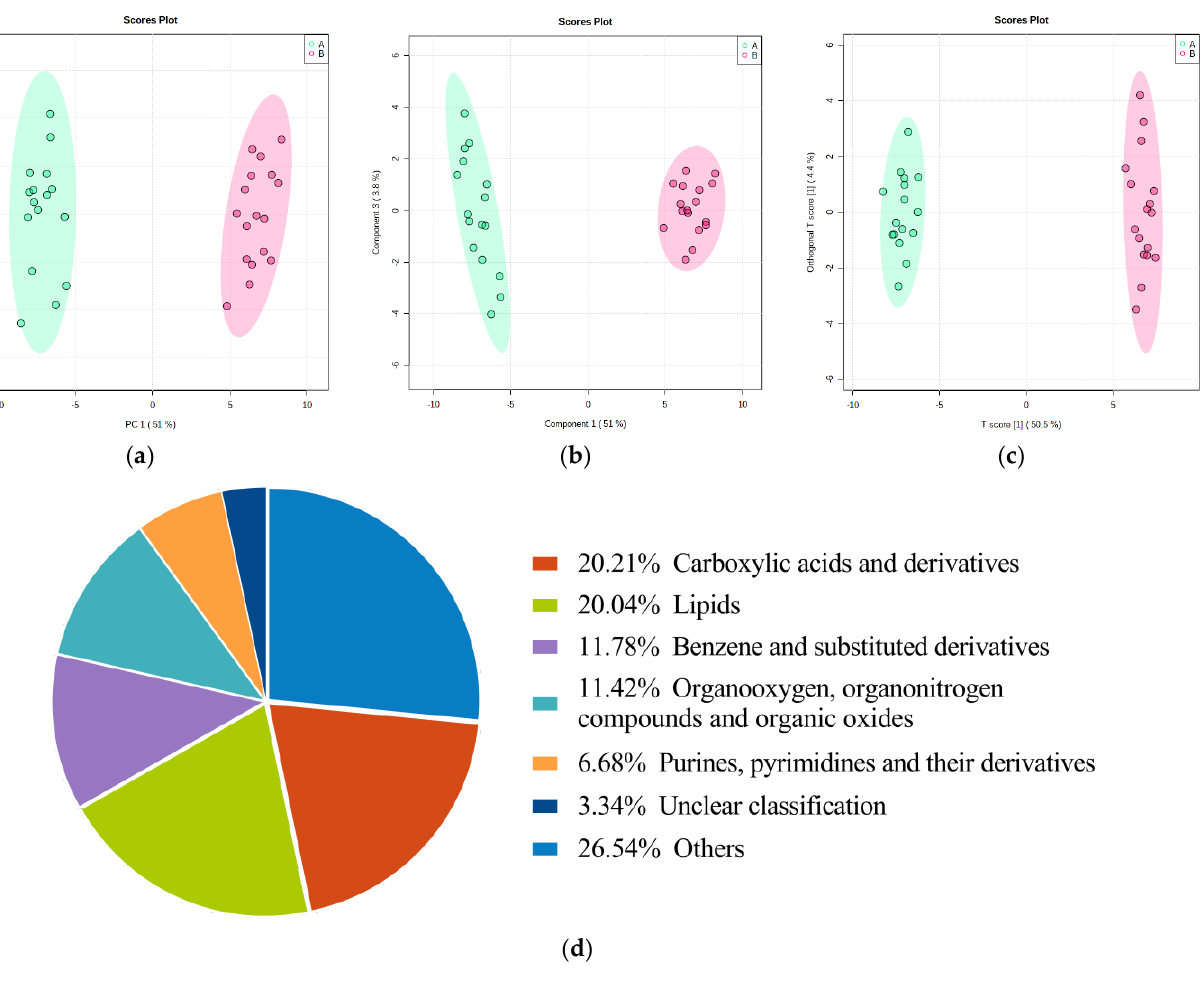
Figure 1. Score plots of the PCA/PLS-DA/OPLS-DA models for discriminating the GV-H group from the GV-L group and pie chart of preliminary differential metabolites screening results in the exploratory set. Samples of these two groups were distinctly separated, indicating that they had markedly different metabolic characteristics ( a – c ). Pie chart ( d ) of differentially metabolomics showed that the 569 metabolites mainly involved carboxylic acids and derivatives (20.21%), lipids (20.04%), benzene and substituted derivatives (11.78%), organic compounds (11.42%), purines, pyrimidines, and their derivatives (6.68%), a few of the detailed classification unidentified metabolites (3.34%), and other